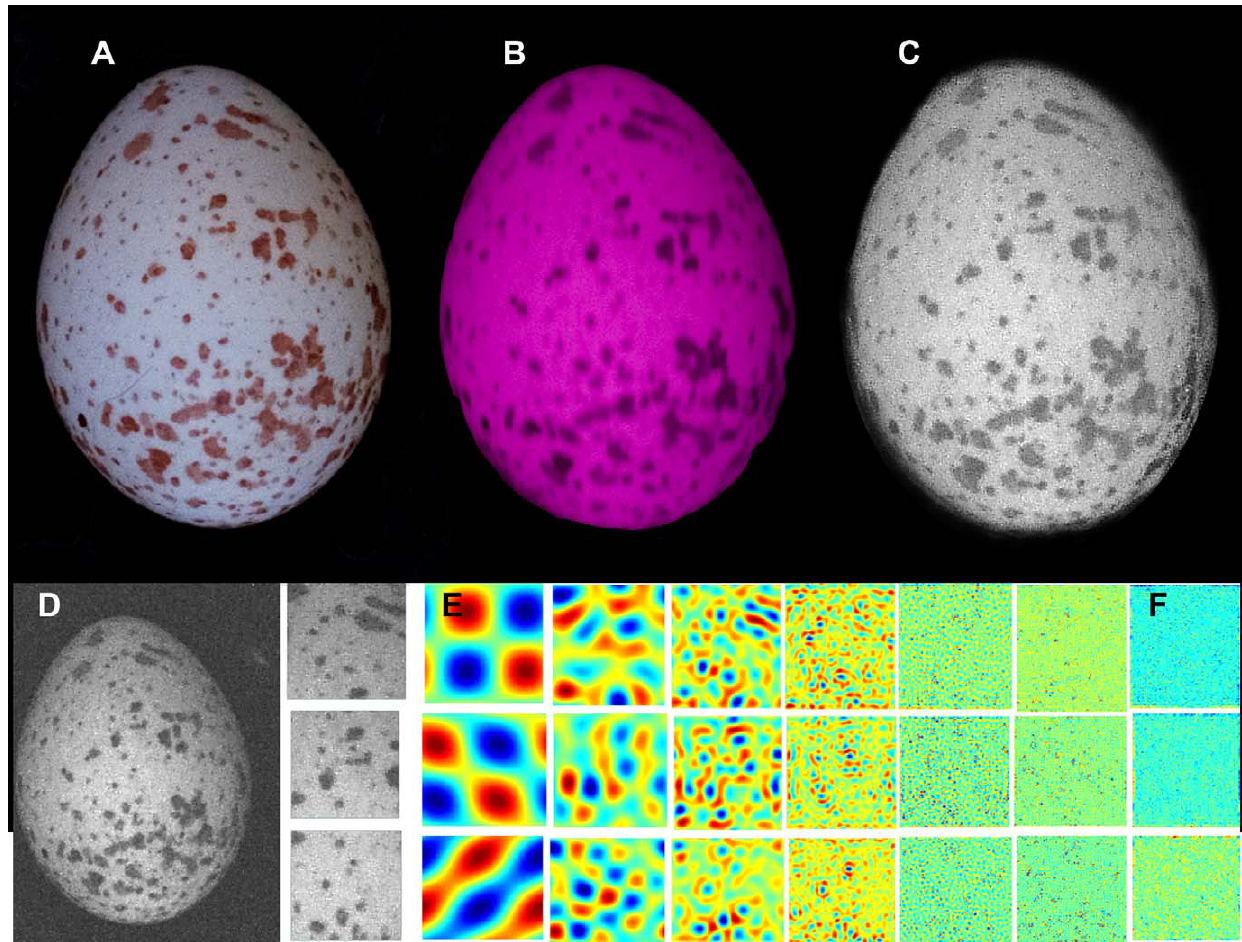
Figure 2. Great tit eggs were photographed in the wild using a UV-sensitive camera, producing images in the (A) human-visible spectrum and (B) ultraviolet spectrum. Images were converted to correspond to a blue tit’s ( Cyanistes caeruleus ) double cones (C) . Egg patterns were measured using a digital image analysis technique (D) based on the fast Fourier transform, in which information about egg speckling is captured at different spatial frequencies. The original image is broken down into seven new images, each containing information at a different spatial scale. Low spatial frequencies (E) capture information about the relative contribution of large markings and high spatial frequencies (F) capture information about the relative contribution of small markings (see Stoddard and Stevens 2010 for details). Egg photograph by M. C. Stoddard.